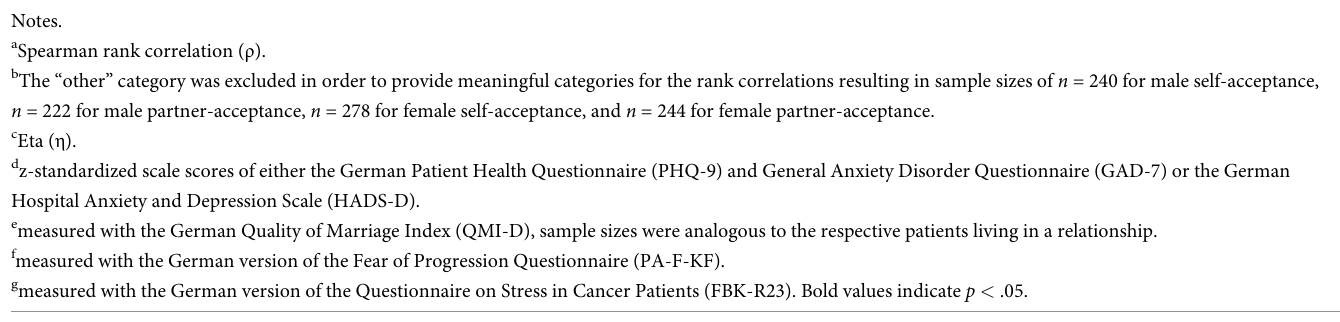
relationship satisfaction, fear of cancer recurrence, and cancer-specific distress. Thus, the men- tioned variables were included in the respective stepwise regression analysis. This had the effect that only the 227 (92.65%) men who were living in a relationship were included in the regression analysis. A separate analysis of the remaining 18 men that were not living in a rela- tionship was not considered statistically purposeful. The resulting model ( R 2 = .266, F (2, 224) = 41.86, p < .001) displayed in Table 3 showed higher relationship satisfaction and lower levels of cancer-specific distress scores to be statistically significant factors associated with higher self-acceptance scores and thus more positive SA in male cancer patients.